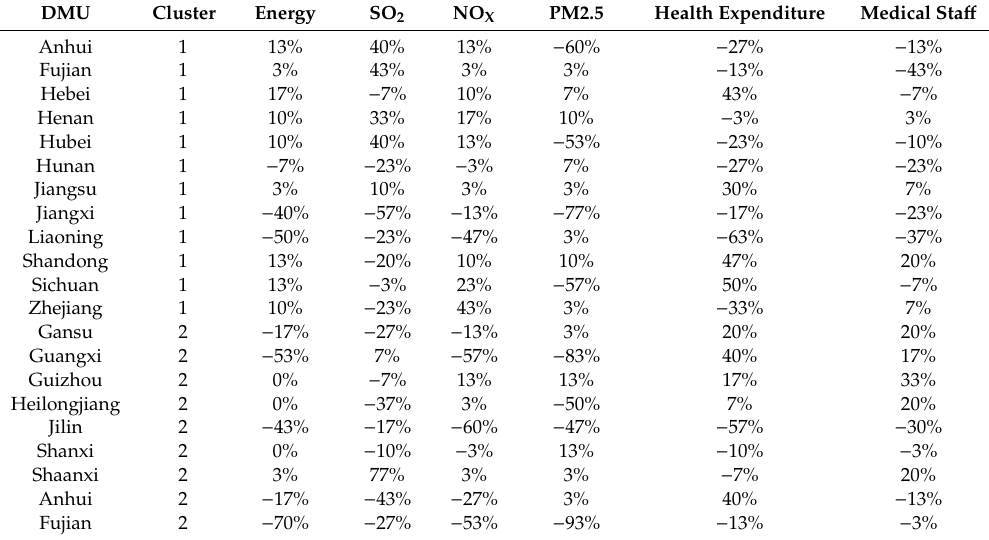
Table 5. Rate of change in index e ffi ciency after